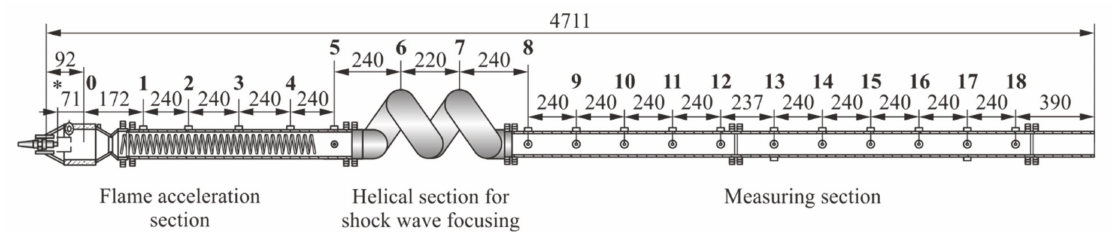
Figure 2. Schematic of the PDT with the indication of measuring segments. Dimensions are in millimeters. The symbol * indicates the place, from which we measure all distances. Actually, this is a position of the gap of the spark